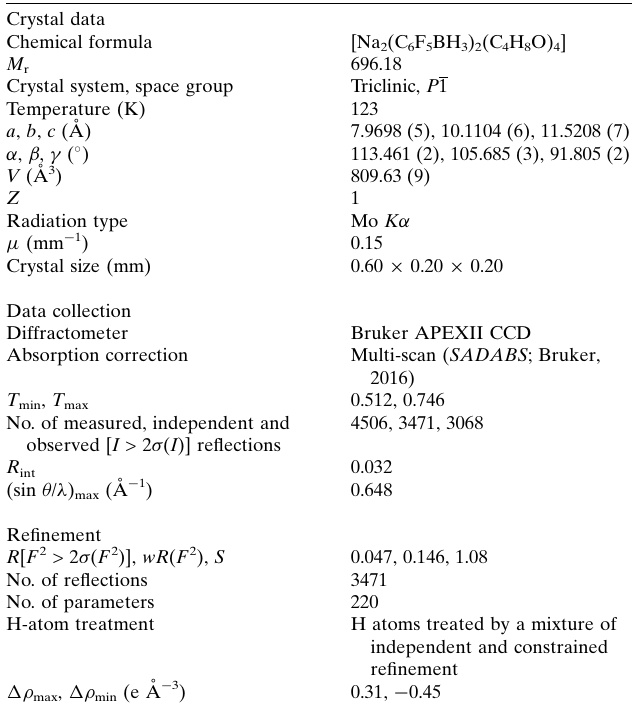
Table 1 Experimental details. Crystal data Chemical